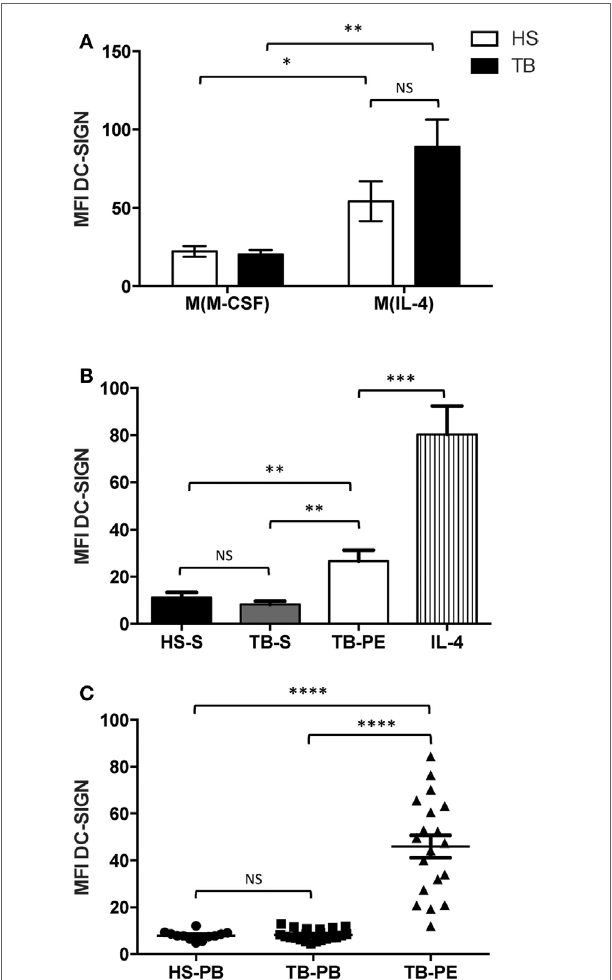
FigUre 2 | Human tuberculosis-associated microenvironment induces DC-SIGN expression in macrophages. (a) DC-SIGN expression is induced in M(IL-4) macrophages from TB patients. Freshly isolated monocytes from healthy subjects (HS, white) and TB patients (TB, black) were differentiated into macrophages using M-CSF. At day 5, the cells were activated with IL-4 (20 ng/ ml) for 48 h to induce the M(IL-4) macrophage program. Otherwise, macrophages were kept under M-CSF to fully establish the M(M-CSF) program. The cells were harvested and the DC-SIGN expression was analyzed by flow cytometry. Vertical bar graphs depicting the median fluorescent intensity (MFI) of DC-SIGN expression in the different cell populations. Results are expressed as mean ± SD ( n = 10 donors). (B) DC-SIGN expression is induced by pleural fluid from TB patients. Freshly isolated monocytes from HS were differentiated into macrophages using M-CSF. At day 5, the cells were activated for 48 h with sera from HS (HS-S, black) and TB patients (TB-S, gray), acellular pleural fluid from TB patients (TB-PE, white), and IL-4 (20 ng/ml, vertical stripes). The cells were harvested and the DC-SIGN expression was analyzed by flow cytometry. Vertical bar graphs depicting the MFI of DC-SIGN expression in the different cell populations. Results are expressed as mean ± SD ( n = 13 donors). (c) DC-SIGN-expressing macrophages are present in the pleural cavity of TB patients. Mononuclear cells were isolated either from peripheral blood from HS (HS-PB) and TB patients (TB-PB), or from the pleural effusions from TB patients (TB-PE), and the expression of DC-SIGN was analyzed on the CD14 + population by flow cytometry. Results are expressed as vertical scatter plots showing the MFI of DC-SIGN for each population; each individual symbol represents a single donor. Two-tailed t -test (unpaired/parametric): *P < 0.05, ** P < 0.01, ***P < 0.001, **** P < 0.0001, NS = not significant